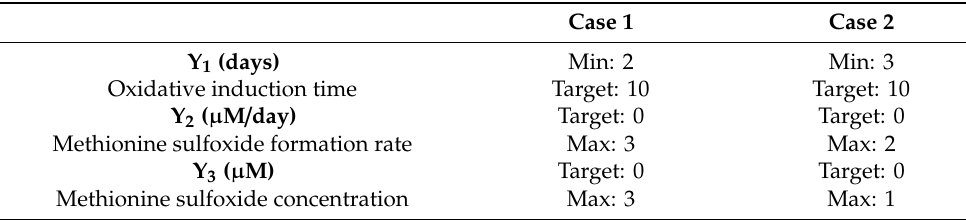
Table 4. Requirements values for each response, in case 1 and